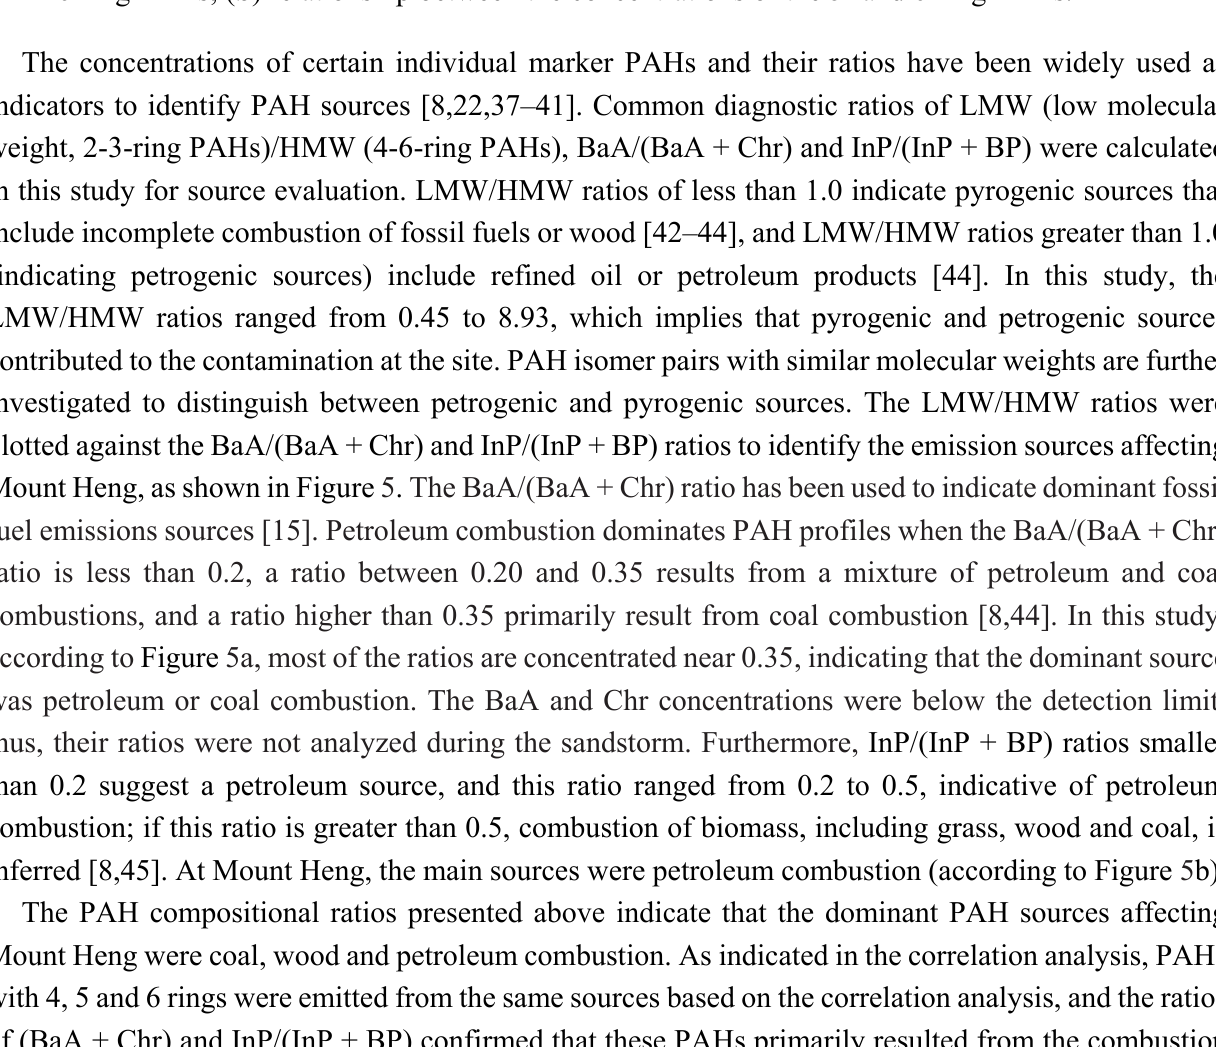
Figure 4. ( a ) Relationships between the 4-ring PAH concentrations and those of 5- and 6-ring PAHs; ( b ) relationship between the concentrations of the 5- and 6-ring